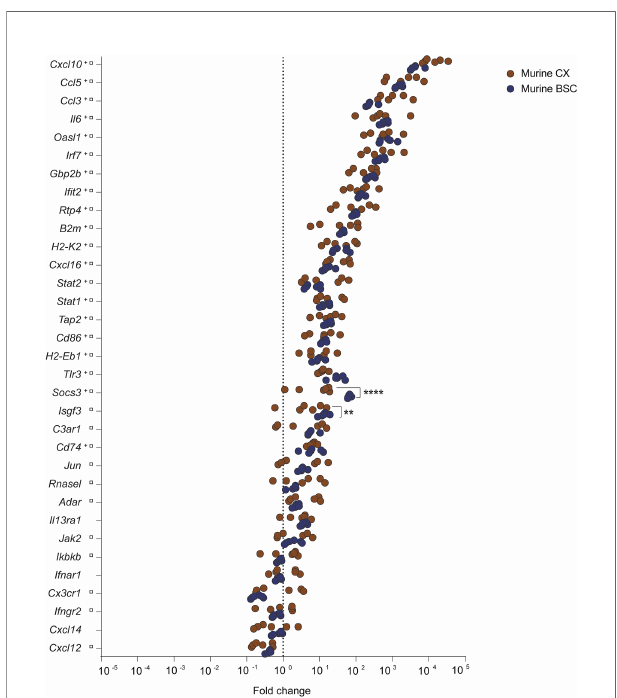
FIGURE 1 | In fl ammatory transcription pro fi le of murine CX and BSC upon RABV strain Tha infection at day 8 post-infection. Scatter plot shows gene expression fold changes in murine CX (n=6) and BSC (n=6), upon Tha infection. Fold changes were calculated based on normalization with the geomean of housekeeping genes Actb and Gapdh ( Supplementary Figure S1 ) as well as non-infected murine CX (n=6) and non-infected BSC (n=6), respectively. Differential expression was calculated by comparing the gene expression ( DD CT values) between murine CX and BSC with the S ̌ ı ́ da ́ k ’ s multiple comparisons test (adjusted p-value ****< 0.0001, **< 0.01). Gene expression in the murine CX ( + ) or murine BSC ( □ ) that differed signi fi cantly from non-infected controls is marked accordingly. A detailed overview of the differential gene expression analysis can be found in Supplementary Table S4